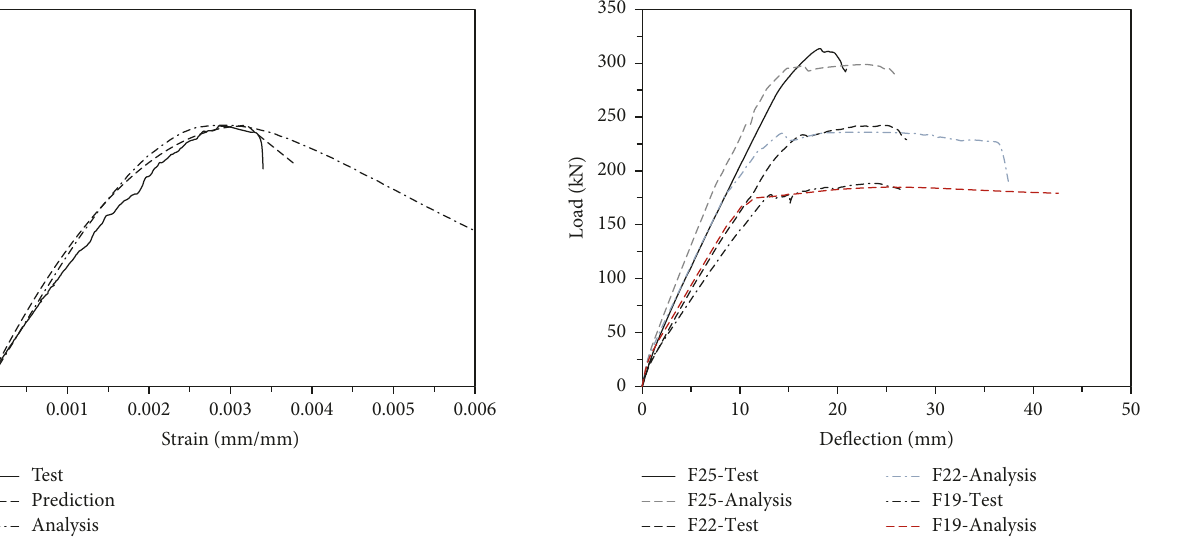
Figure 13: Comparison of experimental and predicted stress-strain curves.